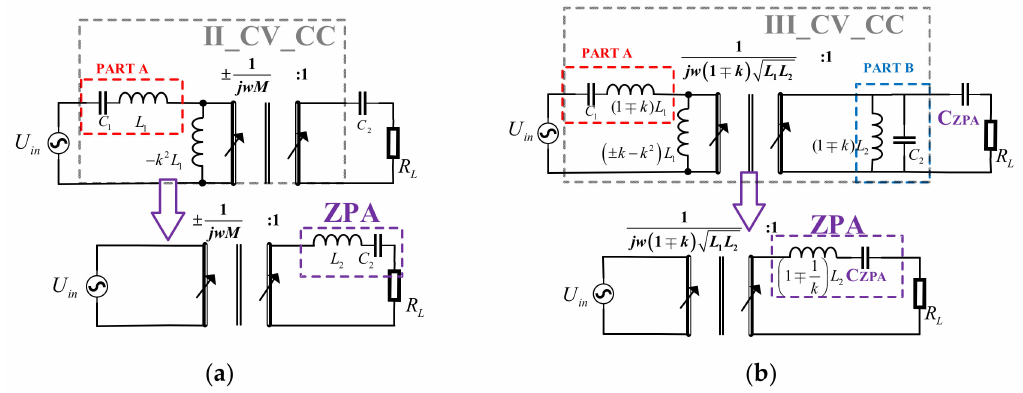
Figure 23. The D_CV_CC type compensation topology: ( a ) S/S [14,15,21–23] and ( b ) S/PS